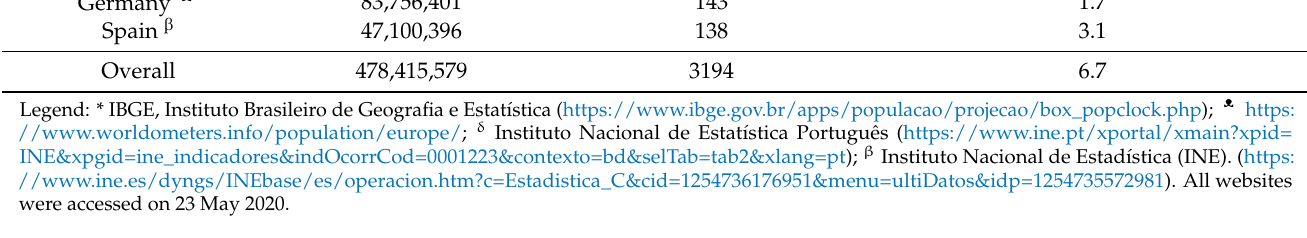
Table 1. Number of respondents per millions of people of the countries’